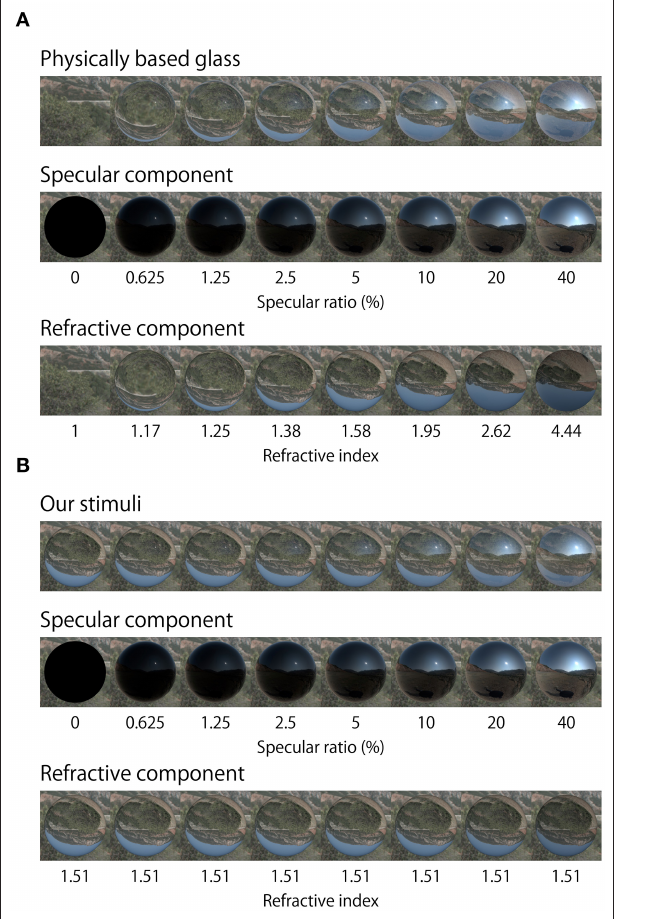
FIGURE 10 | Physically based rendering and our stimuli renderings. (A) Physically based rendering changes object refractive distortion along with specular ratio. Middle and bottom rows show the specular and refractive components of the image on the top row. Refractive images were rendered by variable refractive index. (B) Top row shows objects which were rendered using the method of our experimental stimuli. Middle and bottom rows show the specular and refractive components of the image in the top row. Refractive images were rendered using a fixed refractive